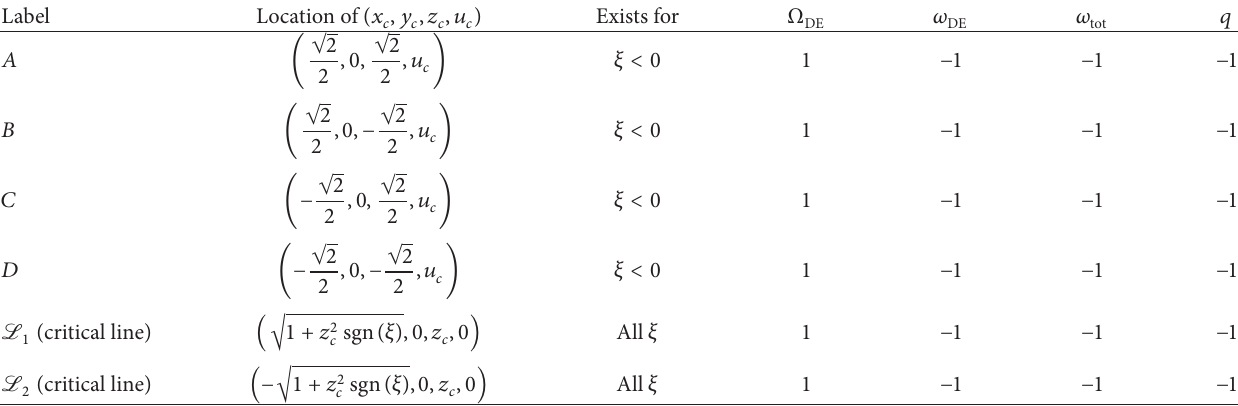
, of the total equation of state parameter 𝜔 DE